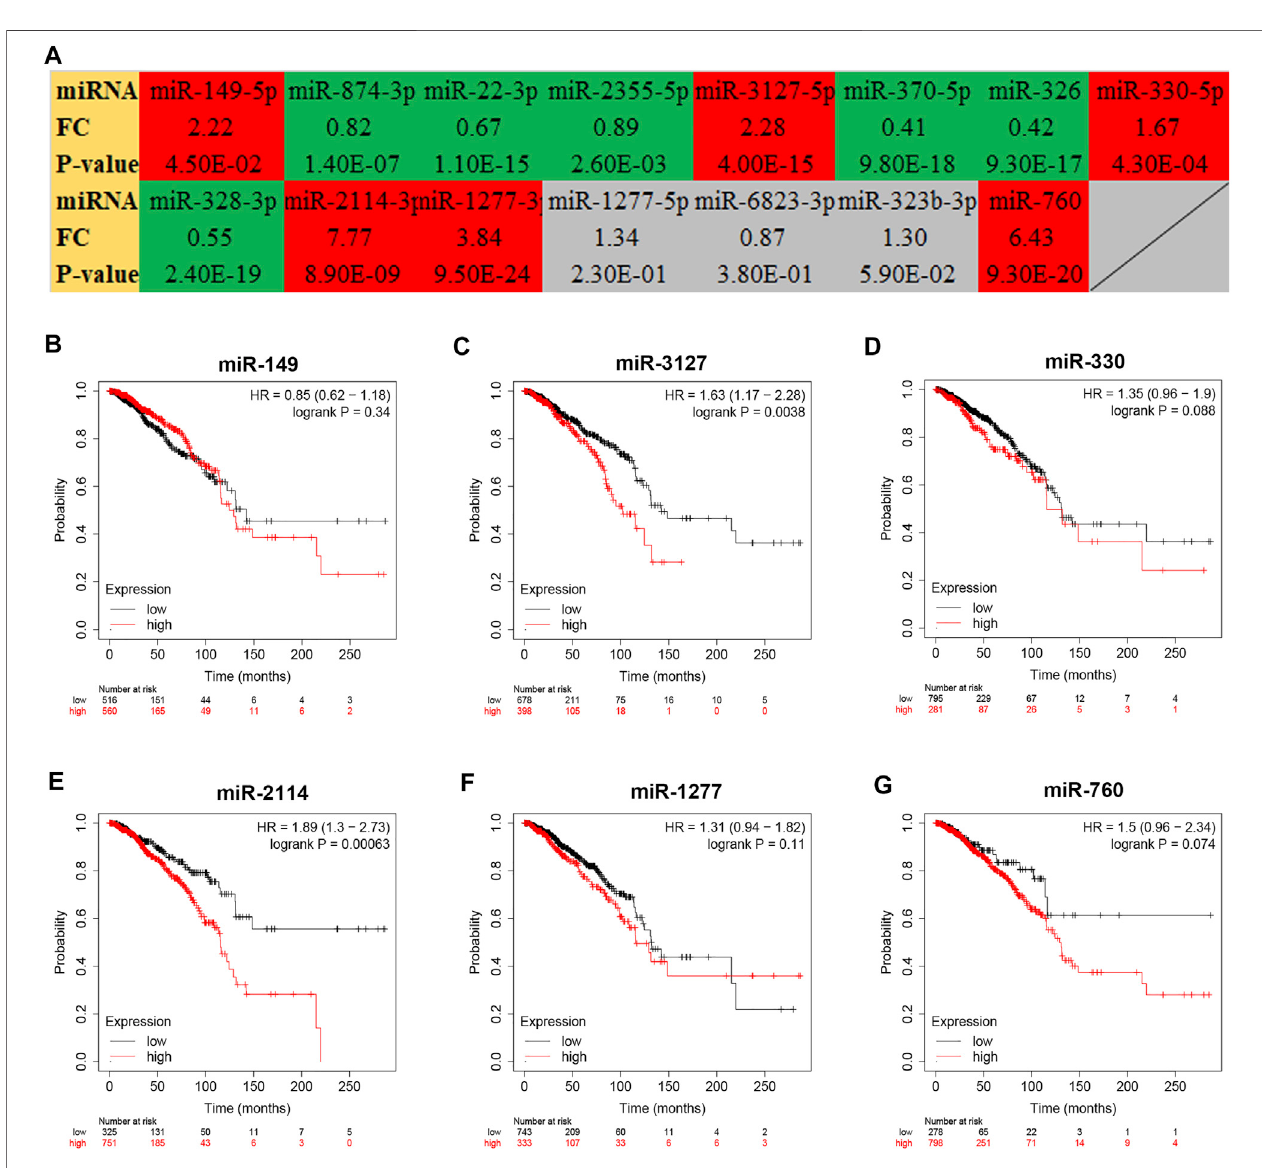
FIGURE 5 | Expression analysis and survival analysis for the miRNAs negatively correlated with LRRC75A-AS1 in breast cancer. (A) The expression levels of 15 LRRC75A-AS1-related miRNAs in breast cancer detected by starBase database. Red: overexpressed in breast cancer; Green: downregulated in breast cancer; gray: nosigni fi cantdifferencesbetweenbreastcancerand normalcontrols. (B – G) TheprognosticvalueofmiR-149-5p (B) ,miR-3127-5p (C) ,miR-330-5p (D) ,miR-2114-3p (E) and miR-1277-3p (F) and miR-760 (G) in breast cancer.